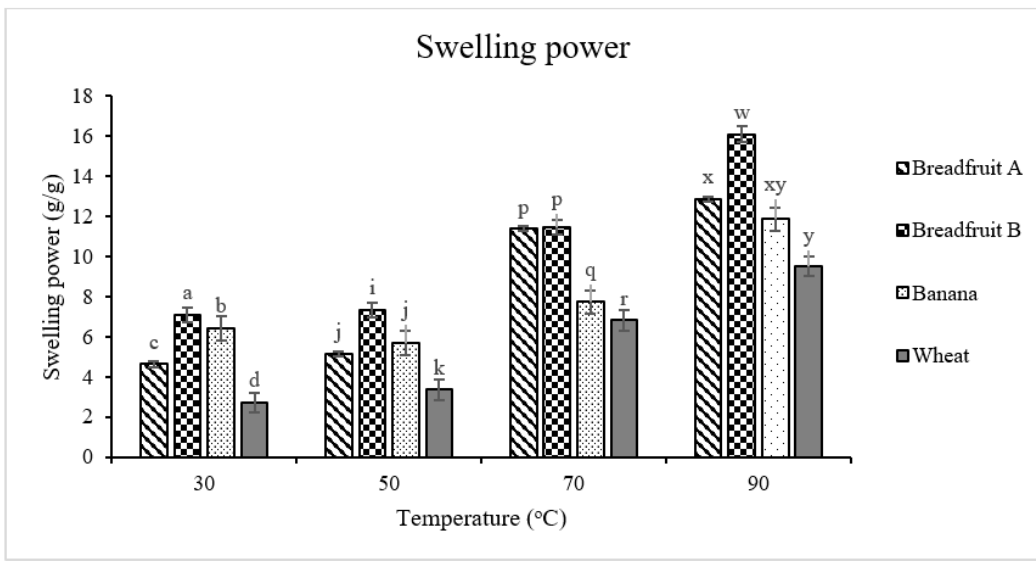
Figure 4. Swelling power of tropical flours compared with a traditional flour. Within each temperature, means without a common superscript di ff er ( p ≤ 0.05). Treatments were flour types of breadfruit A, breadfruit B, banana, or wheat. Breadfruit flour A was sourced from Natural Foods International (Apia, Western Samoa). Breadfruit flour B was sourced from Jungle Project (Alajuela, Costa Rica). Banana flour was sourced from LiveKuna, Kunachia LLC (Davie, FL, USA). Wheat flour was obtained commercially from Bulk Barn Foods (Aurora, ON,